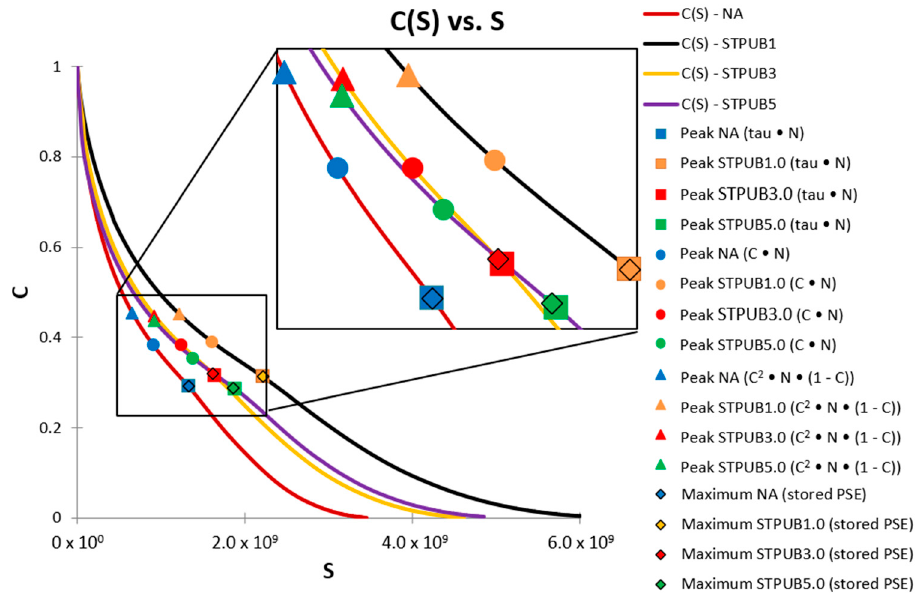
Figure 9. Failure de fi nition points plo tt ed on DCCs.